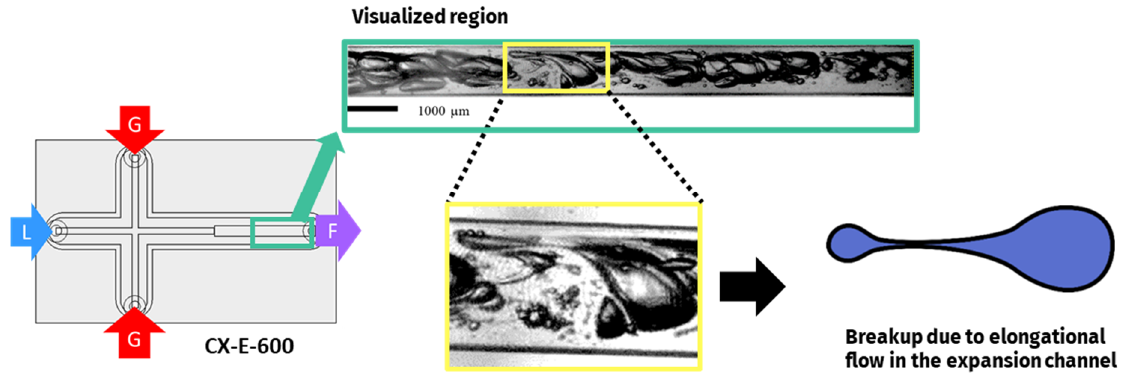
Figure 6. Bubble binary breakup mechanisms identified for the two-phase flow in the expansion channel. Visualizations from device CX-E-600 at a liquid flowrate of 3 L/h. Liquid phase: model solution WPI3XG04. Gas phase: N2. Adapted from [22] with permission from Elsevier.